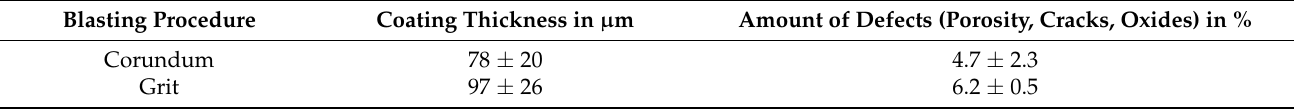
Table 5. The quantitative coating analysis showing thicknesses and defects. Figure 7. Representative SEM images showing the substrate on top and the coating below (specimen bottom) for the samples blasted with ( a ) corundum; ( b ) grit.